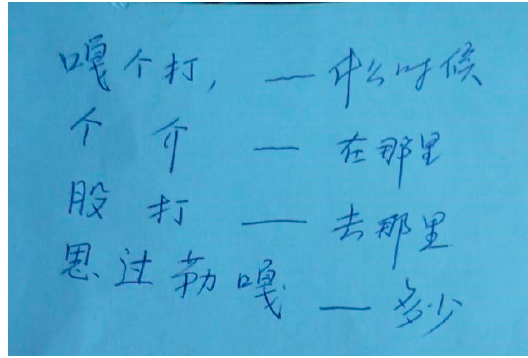
Figure 2. Word ‐ list for employees. Chita.